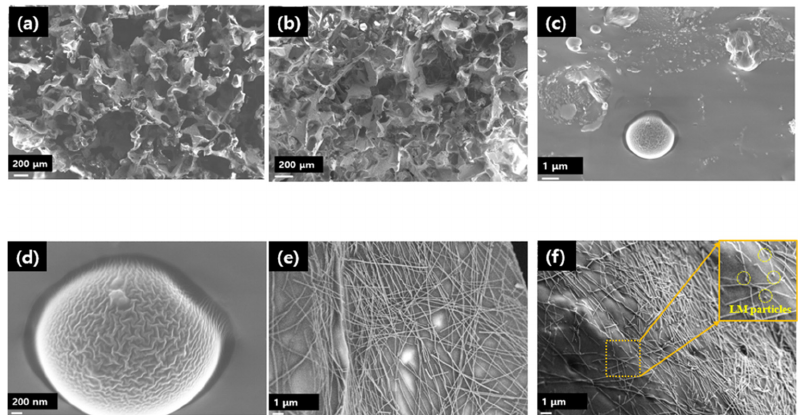
Figure 2. Cross-sectional SEM images of sponge sensors: structure of ( a ) PDMS/AgNW and ( b ) LM/PDMS/AgNW sensors. Images of LM at ( c ) low and ( d ) high magnification, and AgNWs in ( e ) PDMS/AgNW sponge and ( f ) LM/PDMS/AgNW sponge. Inset image indicates the LM particle.